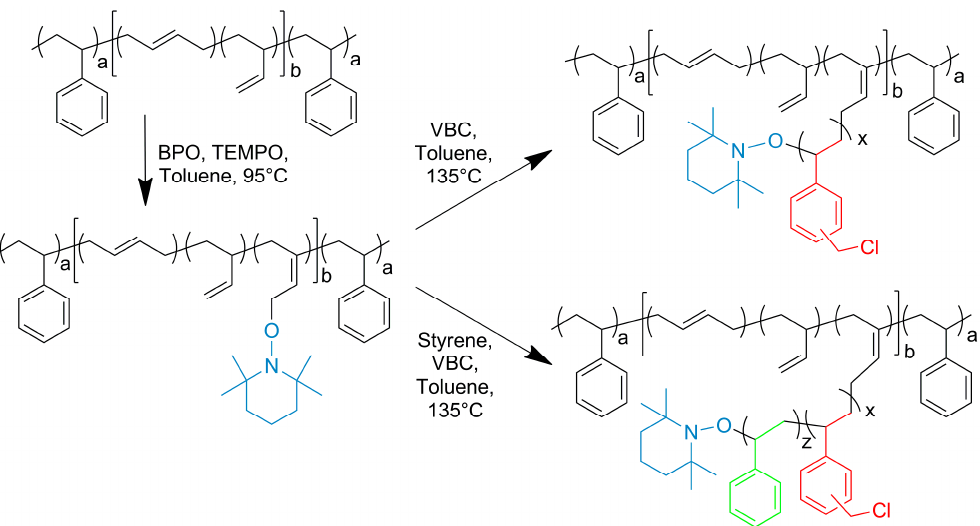
Figure 1. Synthesis of the grafted copolymers g-VBC-x and g-VBC-x- co -Sty-z and the corresponding TEMPO-based SBS macroinintiator. a and b are the mole percentages of styrene and butadiene units in the SBS block copolymer, respectively. x and z are the mole percentages of VBC and styrene units in the grafted chains, respectively. The blue, red and green colors indicate the grafted units of TEMPO, VBC and styrene, respectively on the SBS backbone.